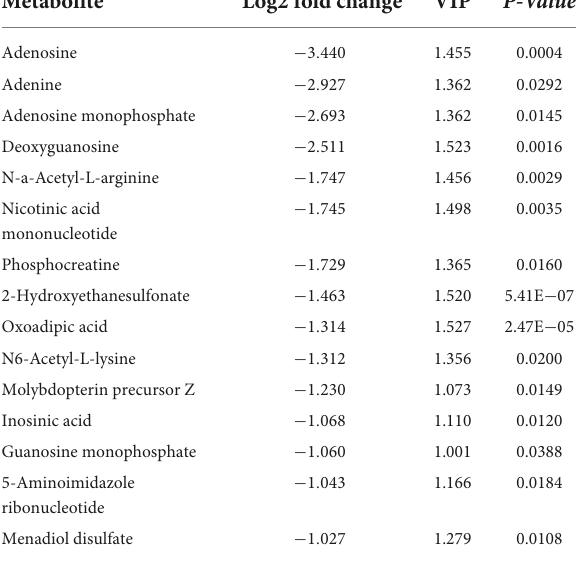
TABLE 3 The top fifteen downregulated differentially expressed metabolites